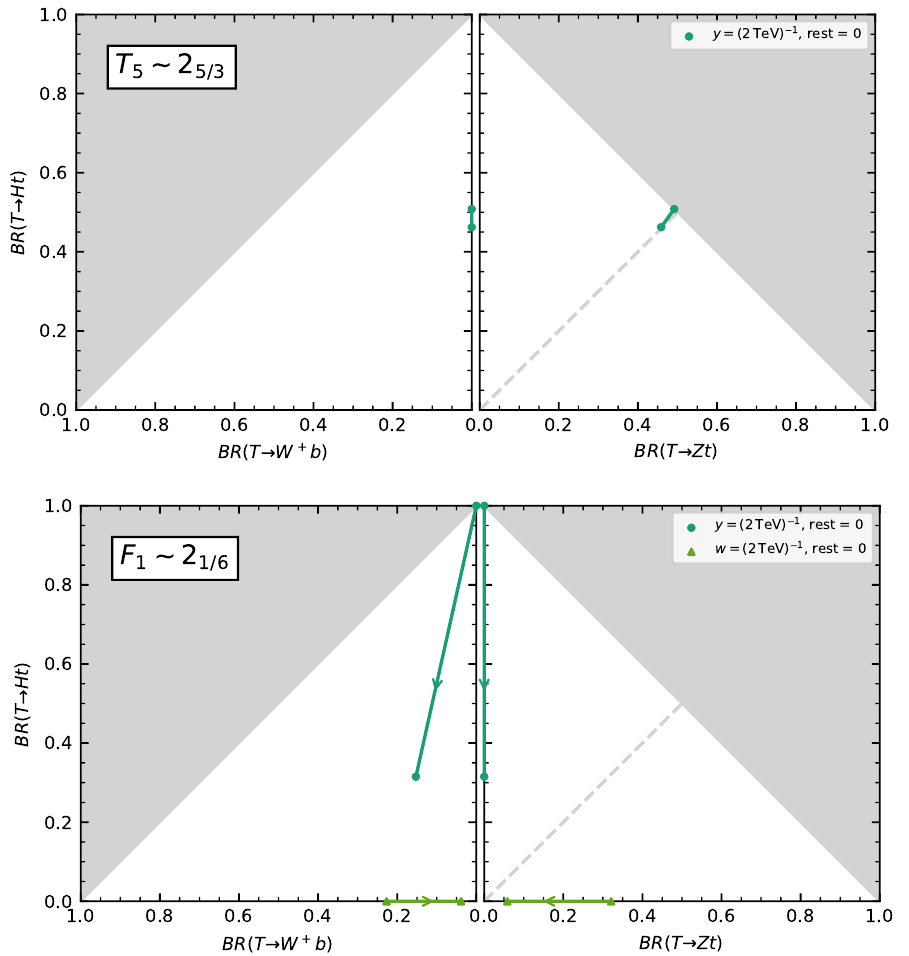
Figure 14 . Branching ratios of T into Ht , Zt and W + b for various values of the parameters in the T 5 and F 7